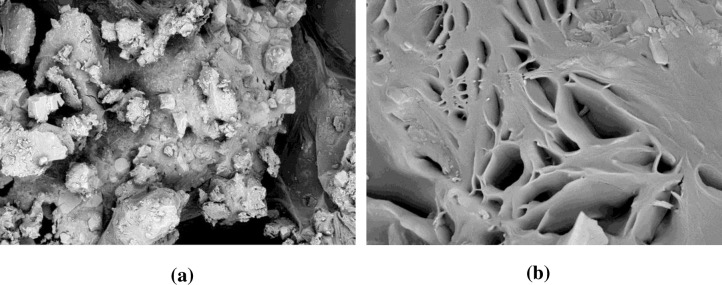
Scanning electron micrographs of pure DCN (a) and the optimized SD (b).